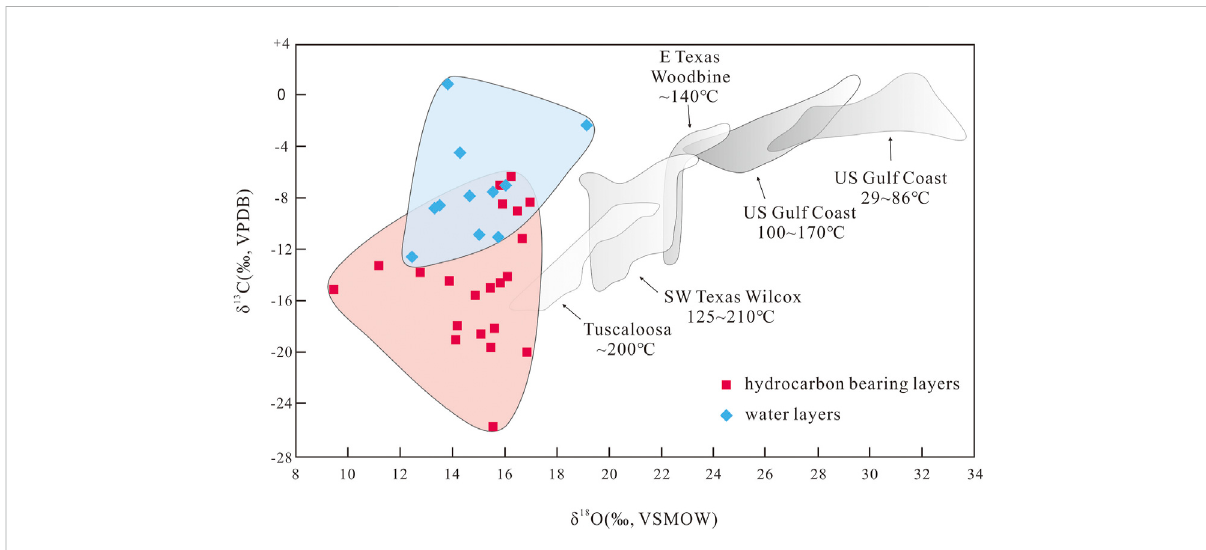
FIGURE 10 δ 13 Cand δ 18 OvaluesofcalcitecementintheP Forester,